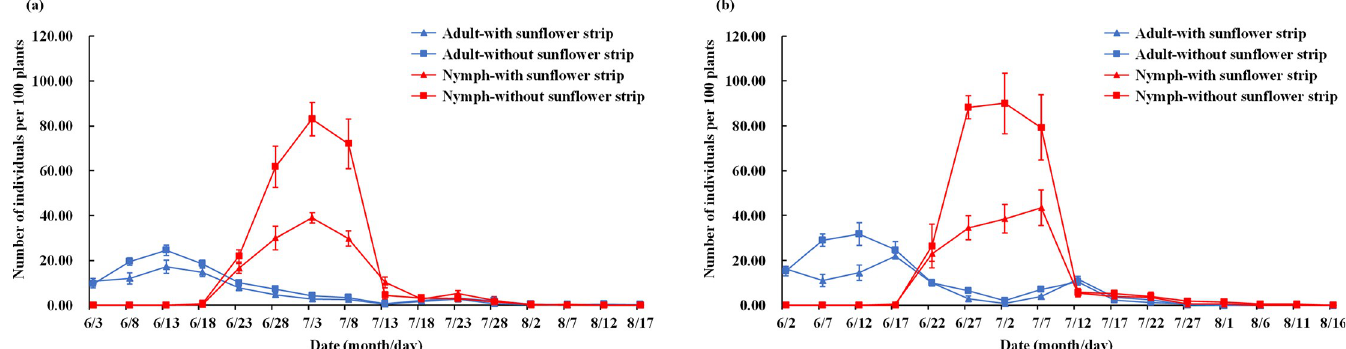
Fig 4. Population dynamics of Lygus pratensis adults and nymphs in cotton fields with and without sunflower strips in 2016 (a) and 2017 (b). Population dynamics of Lygus pratensis adults and nymphs are both in cotton fields which with and without sunflower strip.